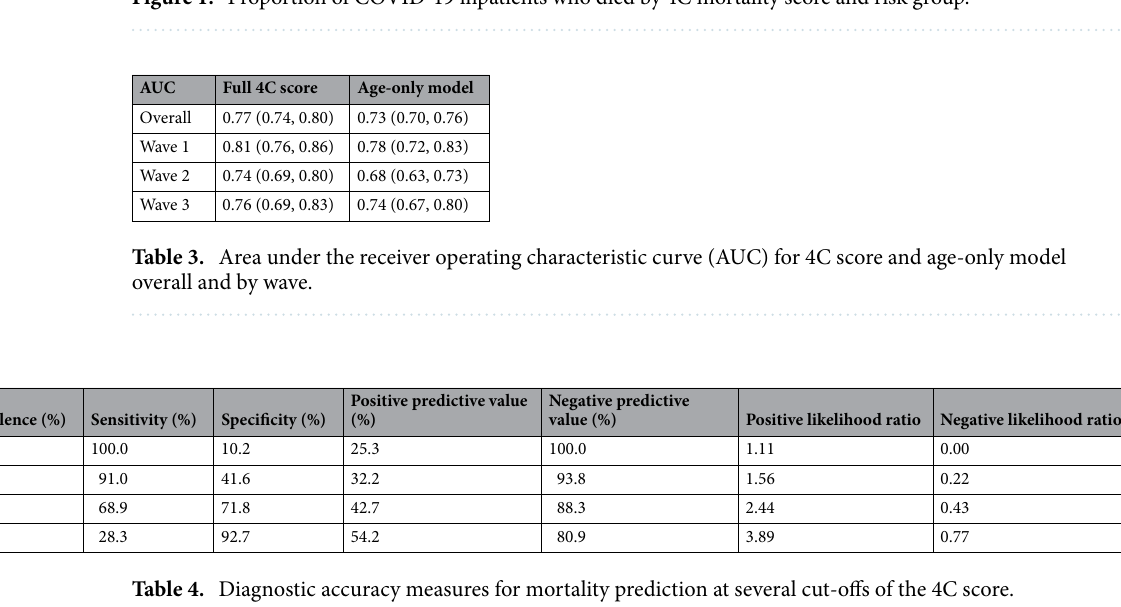
Table 4. Diagnostic accuracy measures for mortality prediction at several cut-offs of the 4C score.